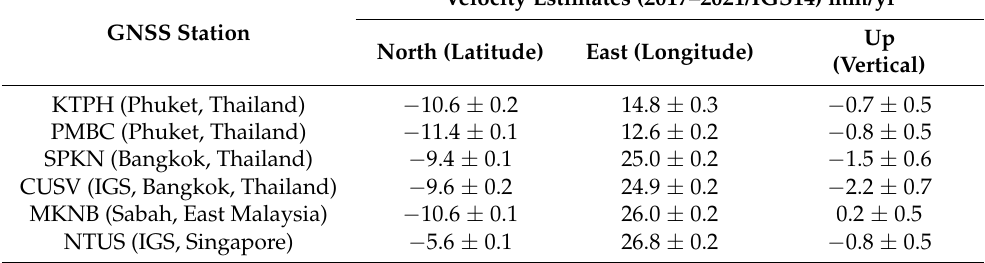
Table 1. Linear trend velocity estimates (2017–2021) in the IGS14/ITRF14 global reference frame for the six continuous GNSS stations in Thailand (4), Singapore (1) and eastern Malaysia (1). Shown are (in the N, E and Up directions) the velocity estimates and standard deviations (1-sigma/68% confidence